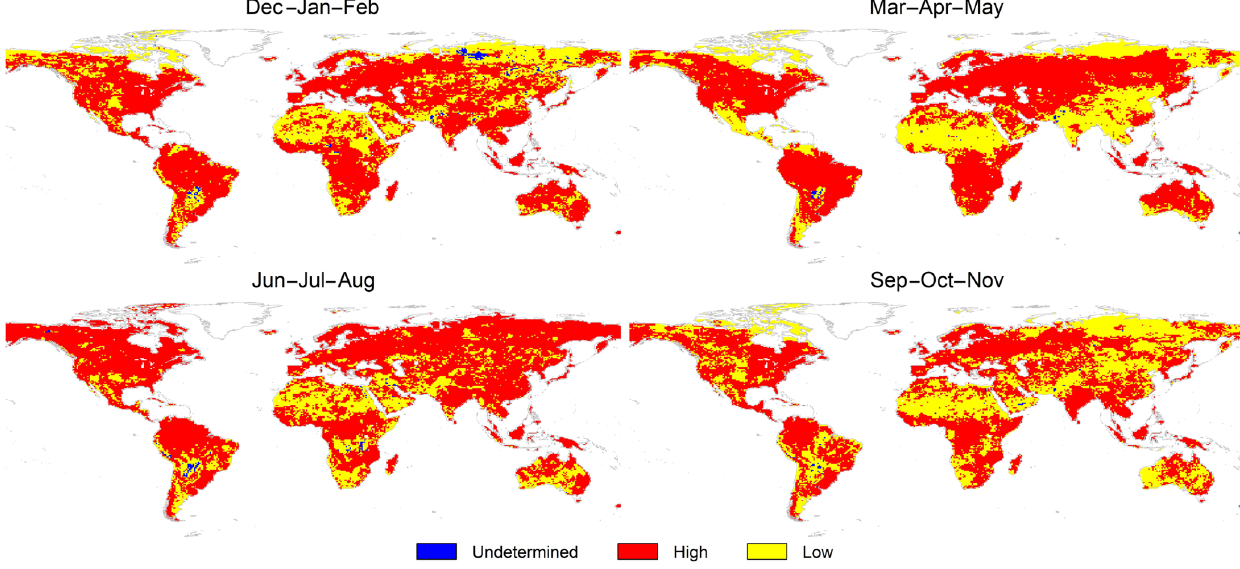
≥ 1, in yellow) and undeter- < 1, in red), low ( mean runoff uncertainty mean runoff mean runoff